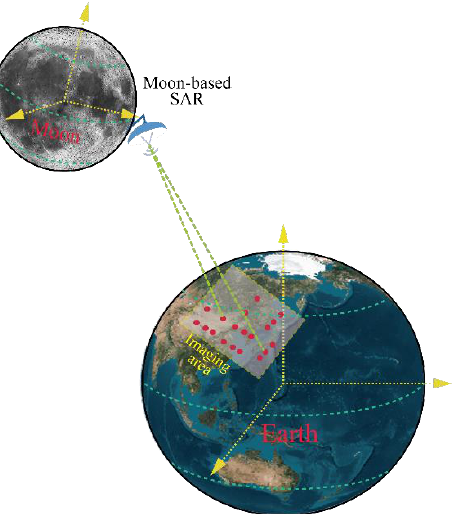
Figure 1. A back-projection imaging processing of MBS (the figure was created using the Adobe Illustrator, a vector graphics software).